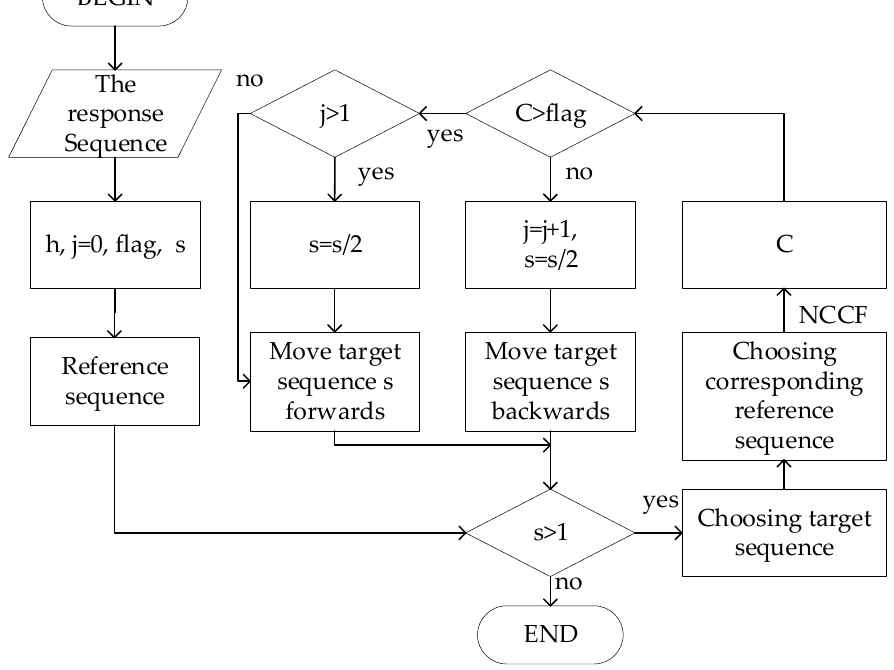
Figure 9. The computational scheme of the method.